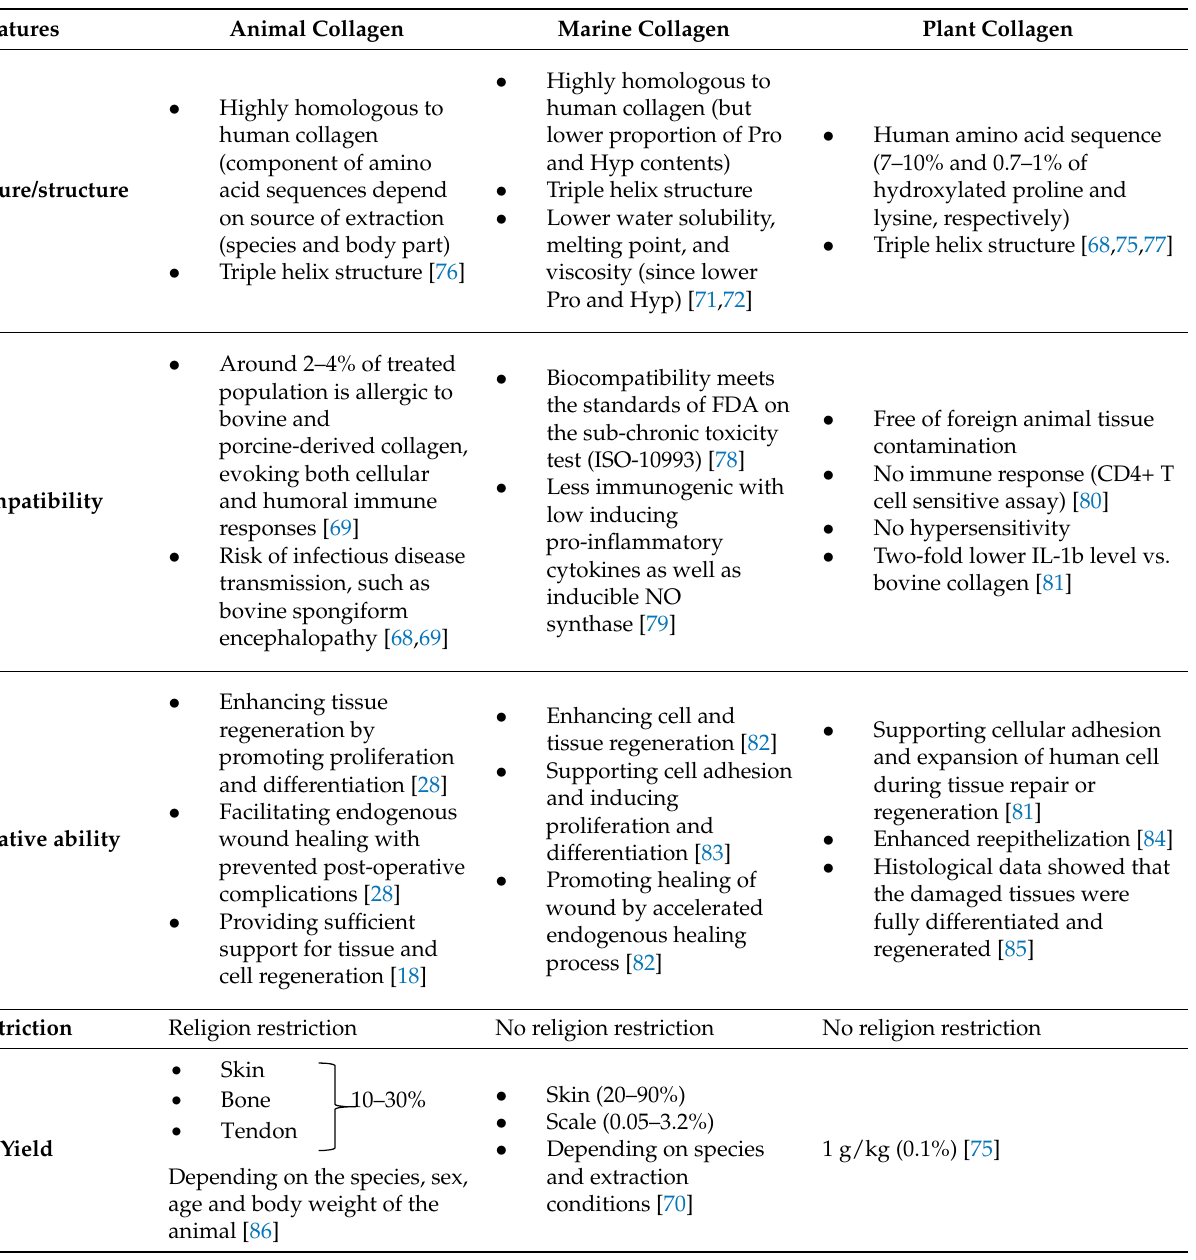
Table 2. Comparison of current sources of medical